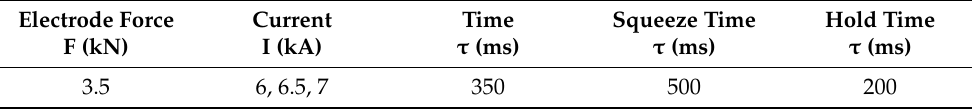
Table 3. Welding parameters used in this study. Electrode